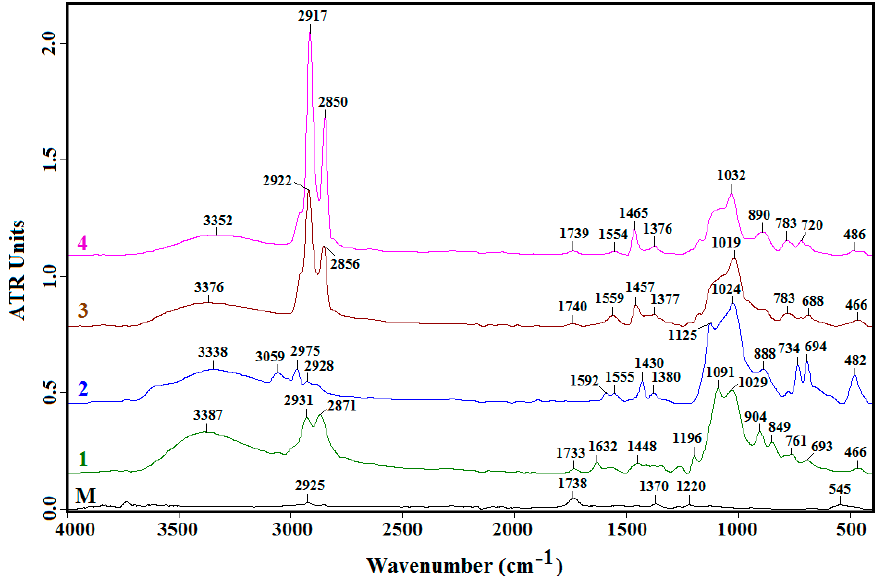
Figure 6. FTIR spectra of unfunctionalized ZnO (M) and of ZnO nanoparticles modified with (1) GPTMS, (2) PhTES, (3) OTES, and (4) ODTES, respectively, deposited onto an aluminum substrate.